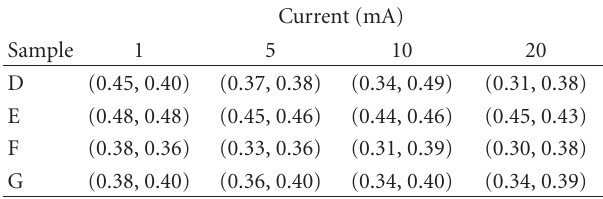
Figure 13: EL spectra in sample G. Injected currents are 1, 5, and 10mA. Table 2: CIE coordinate in all RB-type